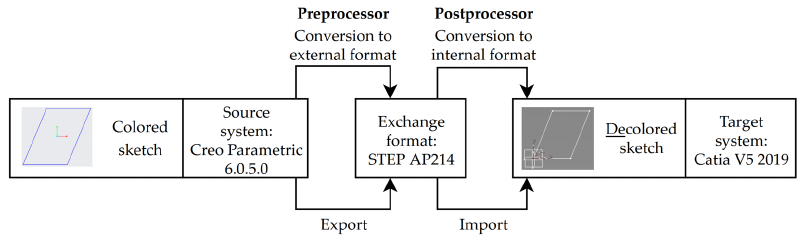
Figure 7. Lossy data exchange of a sketch between the CAD systems Creo and Catia.